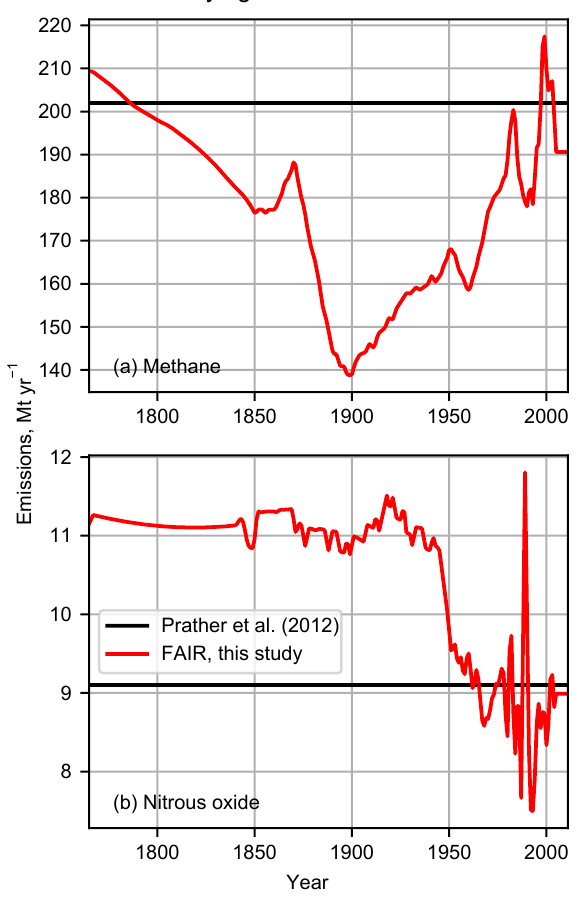
Figure 2. Natural emissions of methane and nitrous oxide used in the FAIR model. Future emissions are fixed at their 2011 val- ues. Also shown are the present-day best estimates of Prather et al.